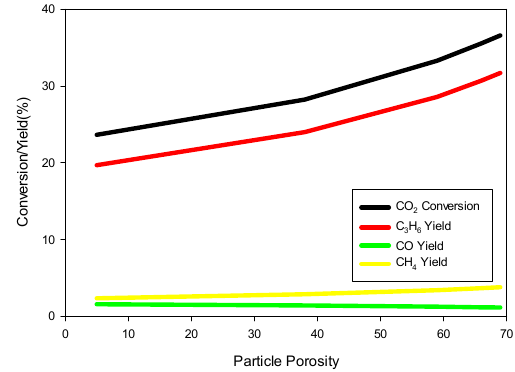
Figure 6. Contours of C 3 H 6 concentration (mol/m 3 ) and formation rate, RC 3 H 6 (mol/(m 3 s)), inside a 250 µ m radius spherical catalyst pellet (80Fe20Cu/K) at 50 mm from the inlet show very small gradients due to high diffusion coefficients of the gas species at 300 °C and 20 bar total pressure.